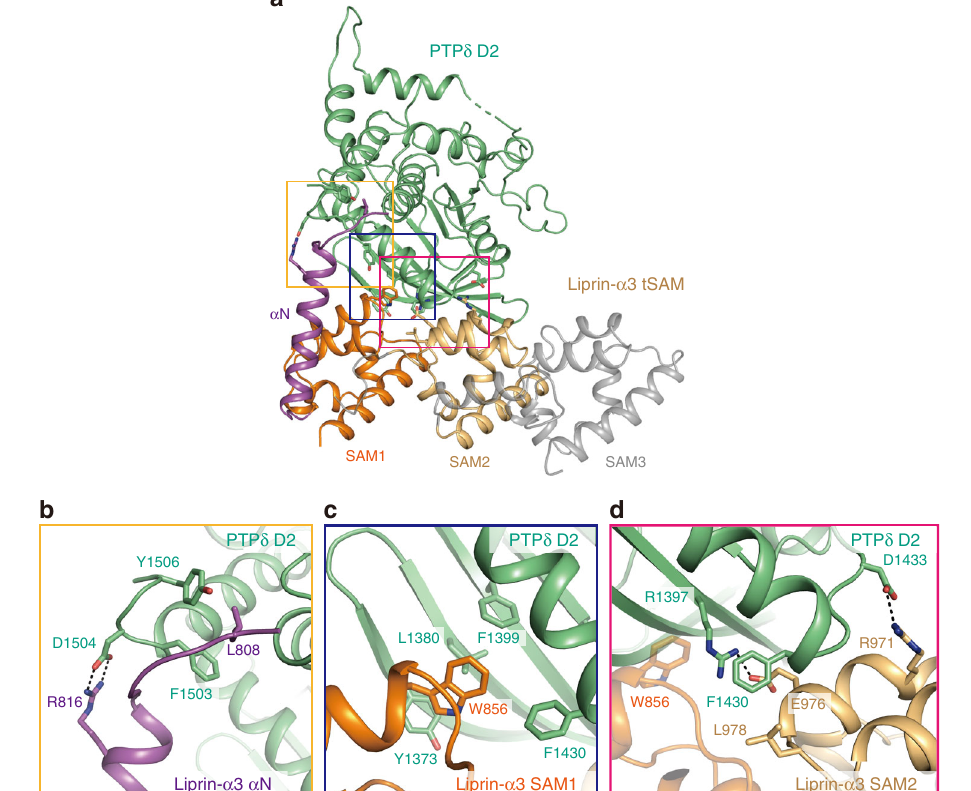
Fig. 2 Binding interfaces between PTP δ D2 and Liprin- α 3 tSAM. a Overall view of the interaction between PTP δ D2 (green) and Liprin- α 3 tSAM ( α N, purple; SAM1, orange; SAM2, light brown; other regions, gray). Disordered regions are shown as dotted lines. The residues involved in the PTP δ D2 – Liprin- α 3 tSAM interaction are shown as sticks. Close-up views of the interactions of PTP δ D2 with α N ( b ), SAM1 ( c ), and SAM2 ( d ) of Liprin- α 3 tSAM. The coloring scheme is the same as that in a . Hydrogen bonds are shown as dotted black lines. Table 2 Mutational analyses of the interaction between PTP δ D2 and Liprin- α 3 tSAM by SPR